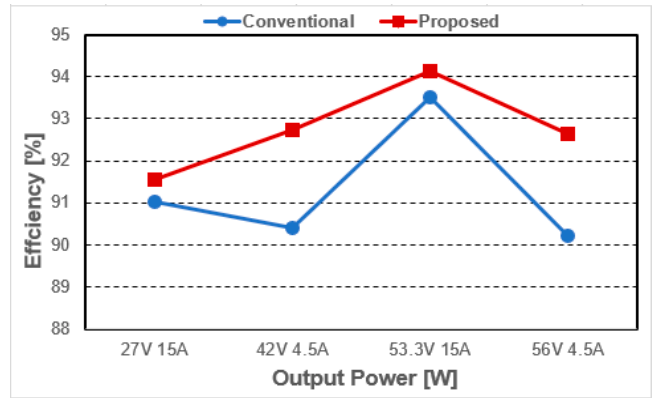
Figure 16. Experimental efficiency.